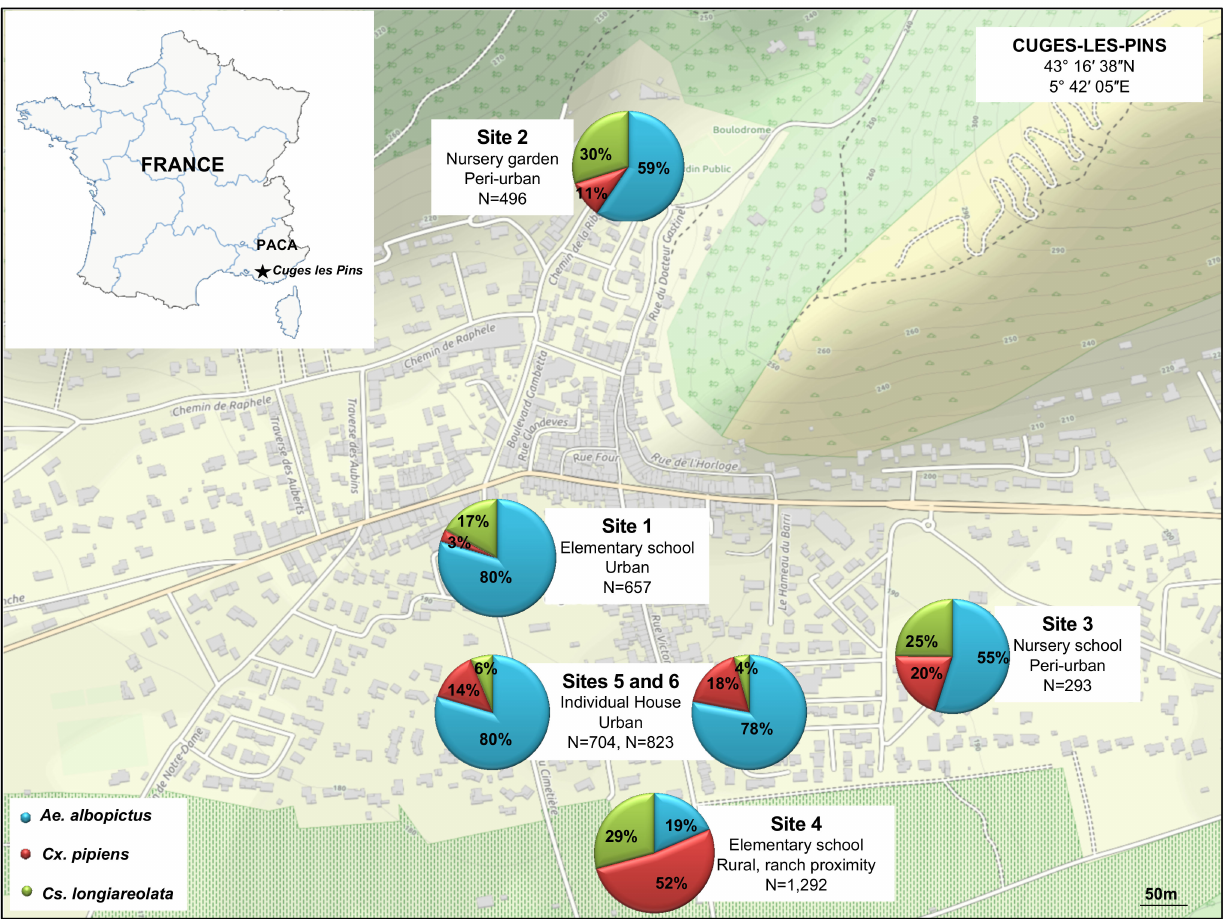
Figure 1. Mosquito collection sites. Map of Cuges-les-Pins area (France) indicated the location of the six sampling sites and the proportion of each of the three mosquito species collected. Ae. albopictus ( blue ), Cx. pipiens ( red ), and Cs . longiareolata ( green